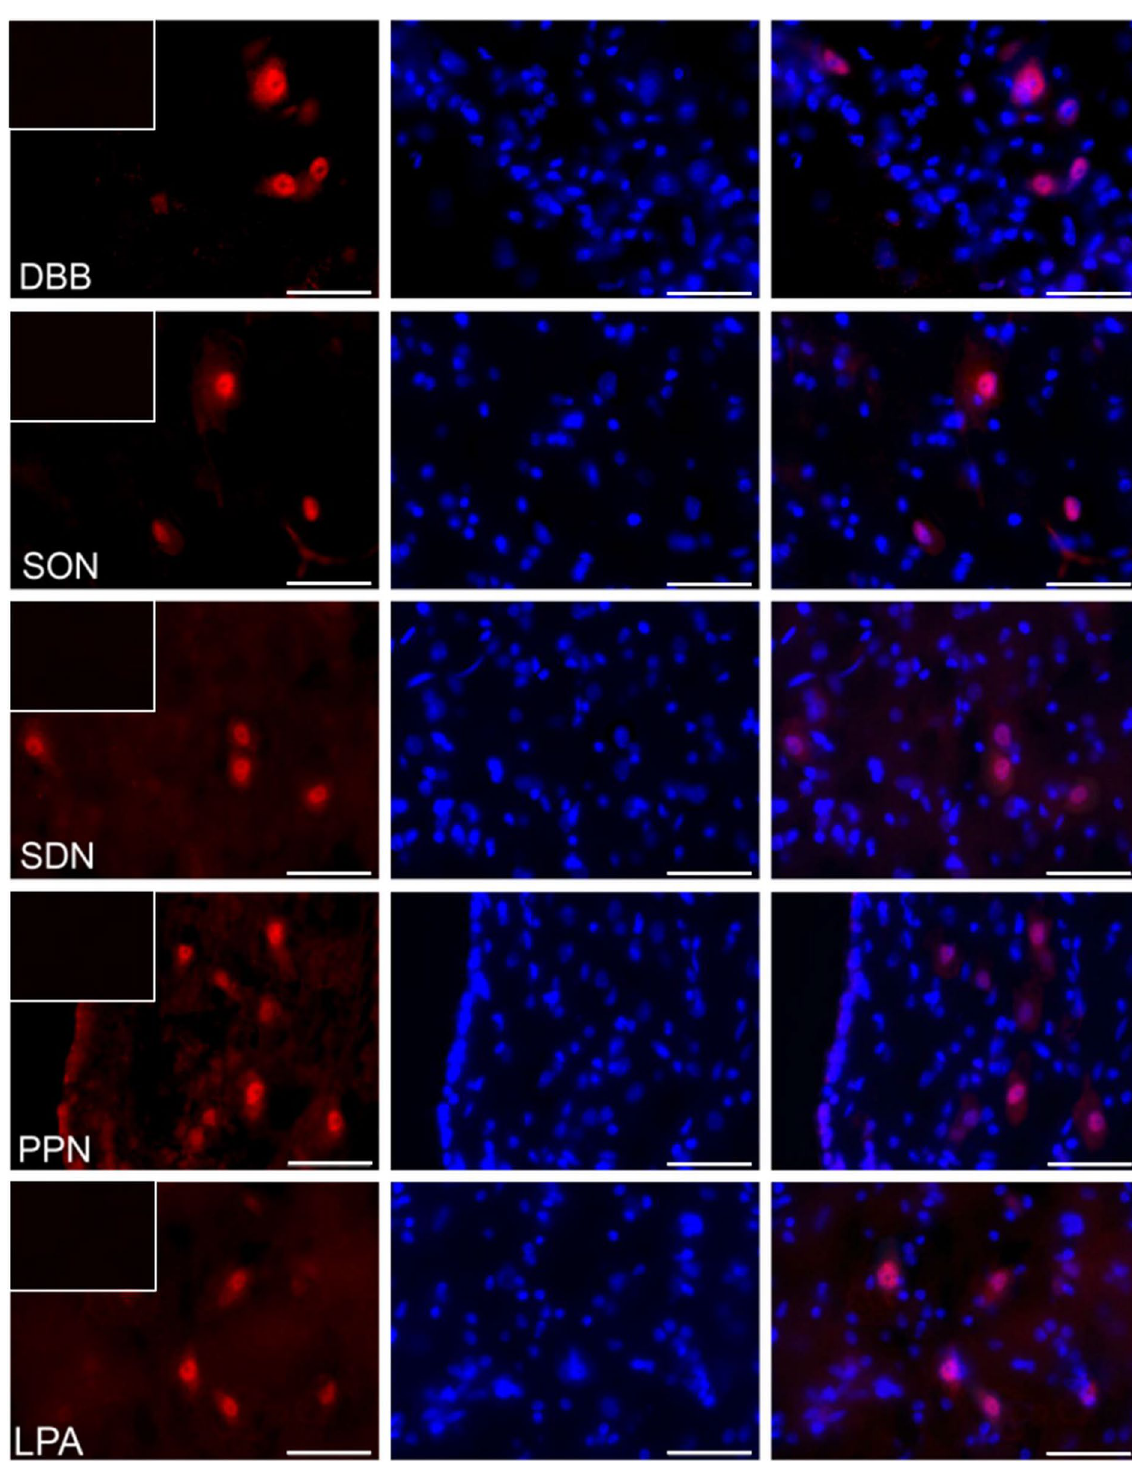
Figure 1. The visfatin localization in the porcine hypothalamus on days 10–12 of the estrous cycle. Immunoreactivity of visfatin was determined by fluorescent immunohistochemistry. Columns from left: first—visfatin expression, visualized by Alexa Fluor 555 as red fluorescence; second—nuclei stained with DAPI, visualized as blue fluorescence; third—merged images of channels (Olympus BX51, Olympus Soft Imaging Solutions, Germany). In the upper left corner of each image in the first column—negative control, where the primary antibody were replaced with non-immunosera. Particular images indicate the immunolocalization of visfatin in the diagonal band of Broca (DBB), supraoptic nucleus (SON), preoptic area (SDN), periventricular nucleus (PPN), lateral (LPA) and medial preoptic area (MPA), paraventricular nucleus (PVN), suprachiasmatic nucleus (SCN), arcuate nucleus (ARC), as well as ventromedial nucleus (VMH). Immunofluorescent staining was repeated on three pigs. Scale bar: 50